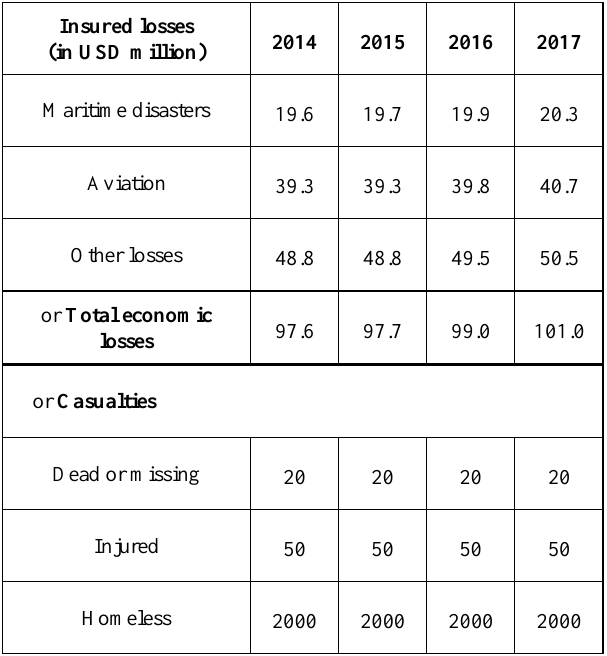
Table 1. Sigma event selection criteria for